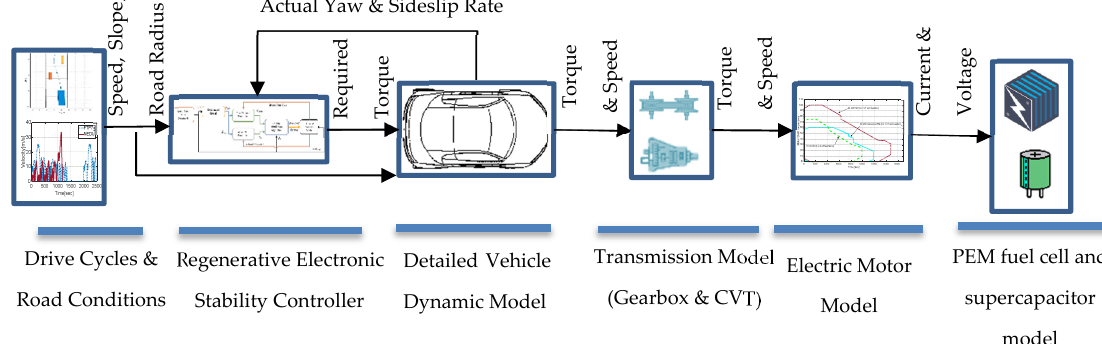
Figure 1. Block diagram of the developed model.